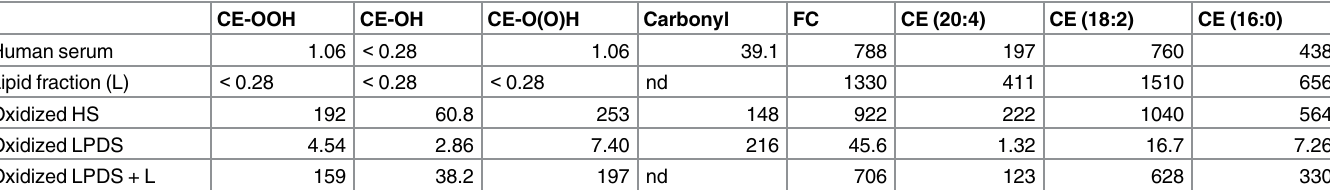
Table 1. Contents of lipid peroxidation products, protein carbonyl, and lipids in human serum samples used in this study a